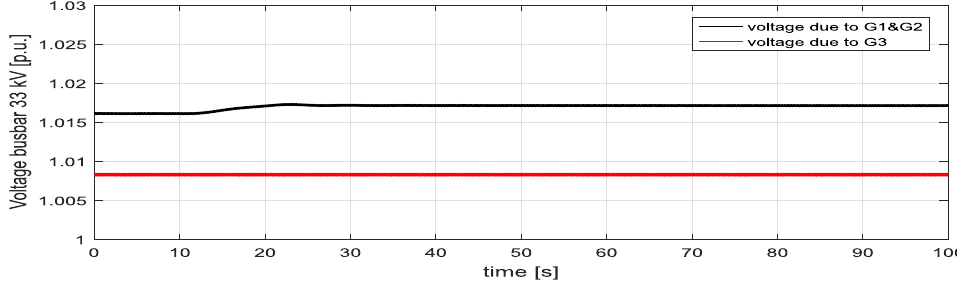
Figure 16. Time evolution of voltage on the busbar at 33 kV.